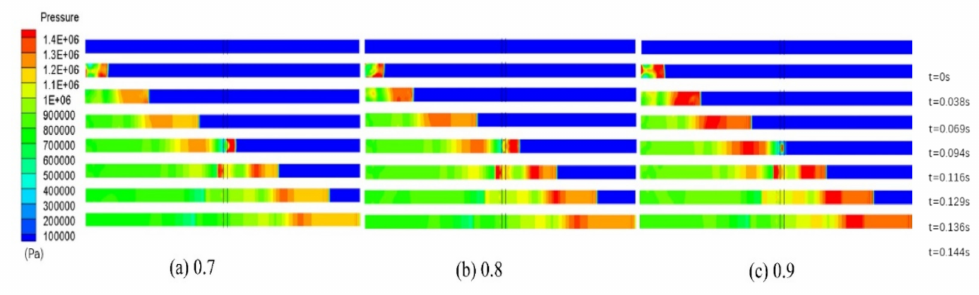
Figure 15. Comparison of pressure cloud of metal foam with different